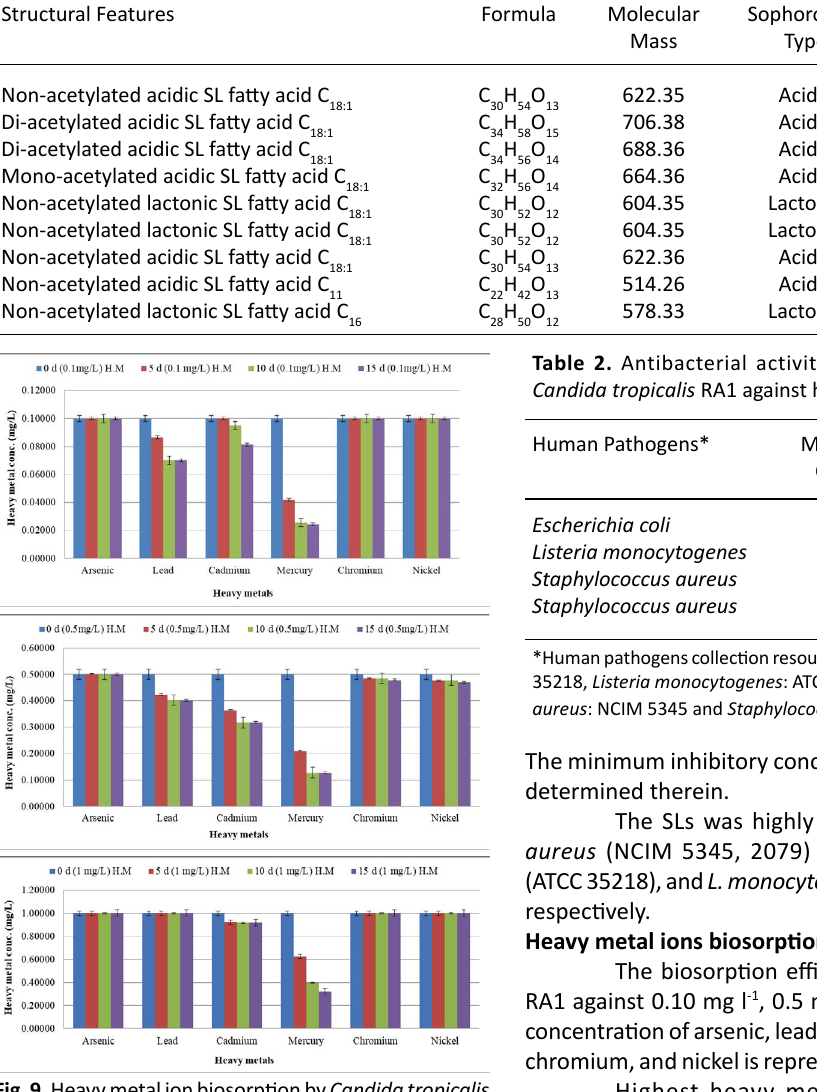
Table 1. The chemical formula, molecular mass, and structural features of sophorolipid homologues by Candida tropicalis RA1 determined using LC–MS Structural Features